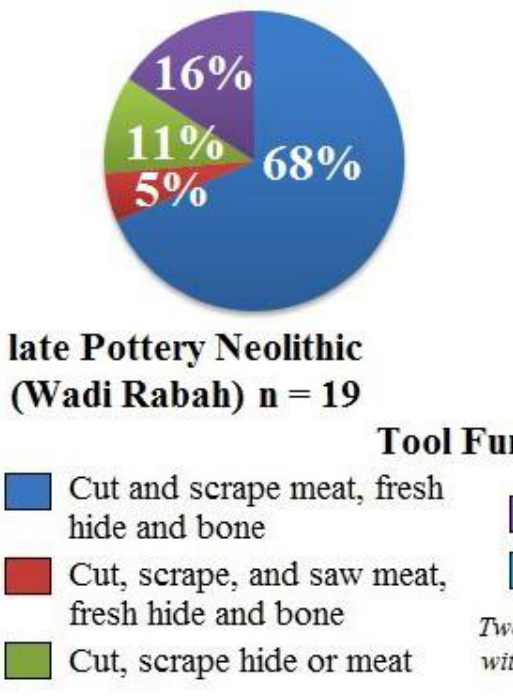
Figure 1. Microwear on utilized late pottery Neolithic and Early Bronze Age fan scrapers and spalls from the Ein Zippori Site, Isreal. Frequencies of different tool functions for utilized fan scrapers and fan scraper spalls in late Pottery Neolithic (PN) and Early Bronze Age (EBA) layers Ein Zippori. Chi-square test showed no significant difference between periods. Most fan scrapers were used for skinning and butchering animals and processing hides. Scrapers from late PN levels were also used to scrape bone, and scrapers from EBA levels were also used to scrape hides with thicker fat layers that may have been treated with abrasives. From Tables 1 and 2. Two fan scrapers from late PN levels with weak generic microwear are not